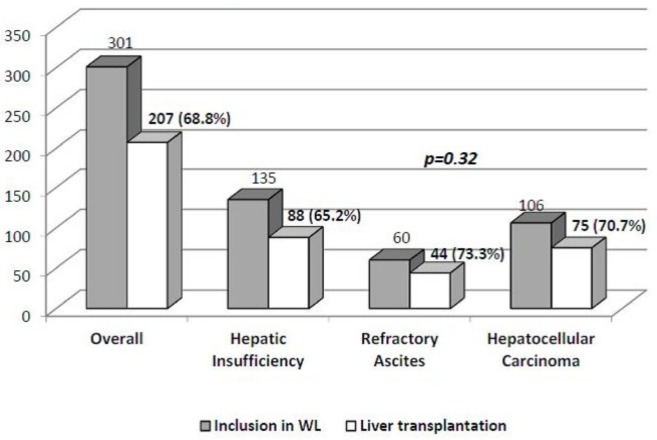
Probability of liver transplantation